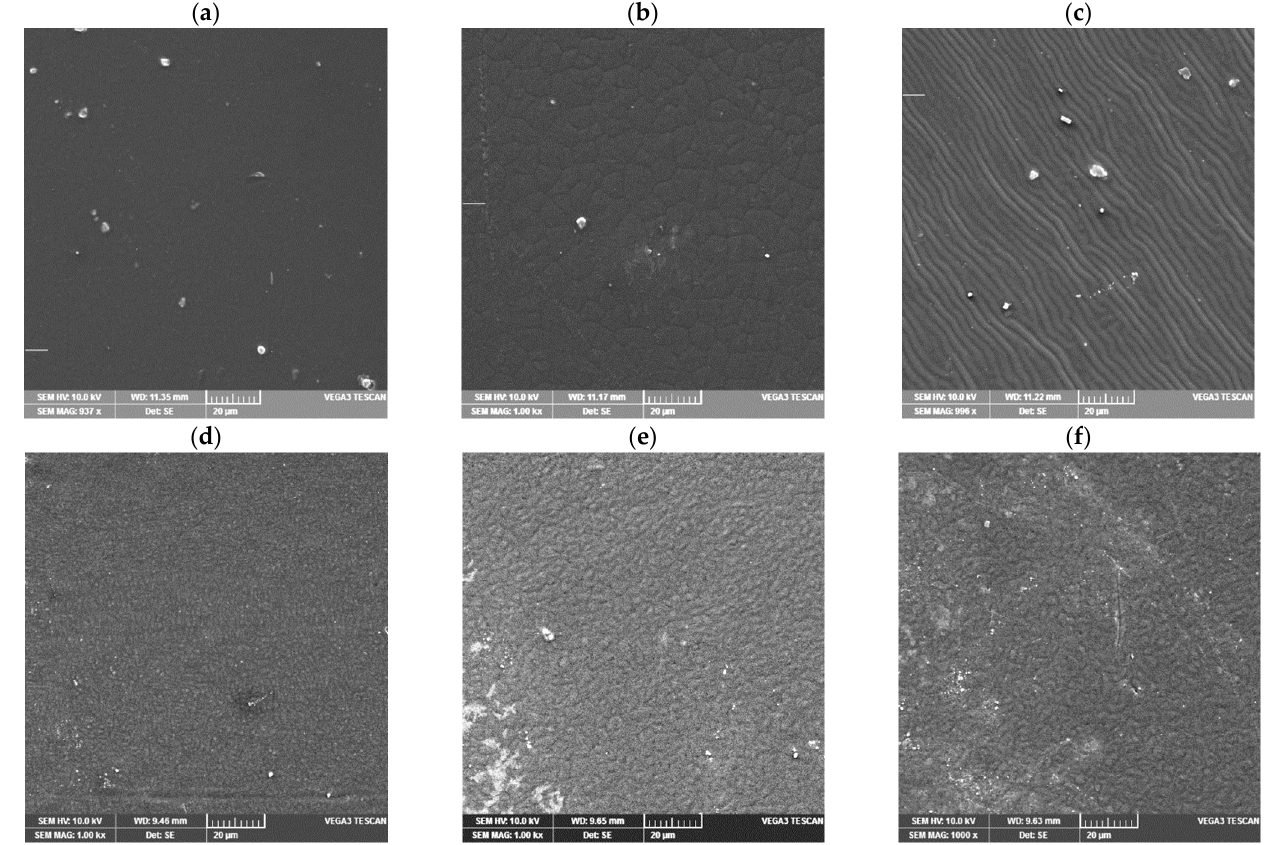
Figure 6. SEM micrographs of PE/PCL films: ( a ) PE/PCL-Al 1, ( b ) PE/PCL-Al 5, ( c ) PE/PCL-Al 10, ( d ) PE/PCL-C-Al 1, ( e ) PE/PCL-C-Al 5, ( f ) PE/PCL-C-Al 10.